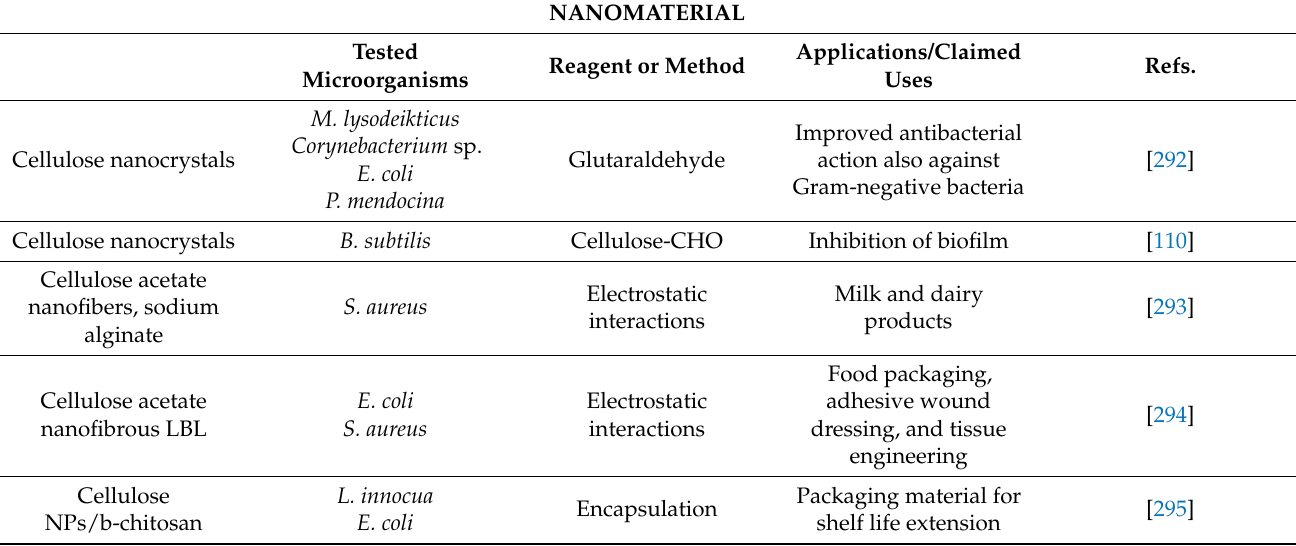
Table 6. Lysozyme modifications and